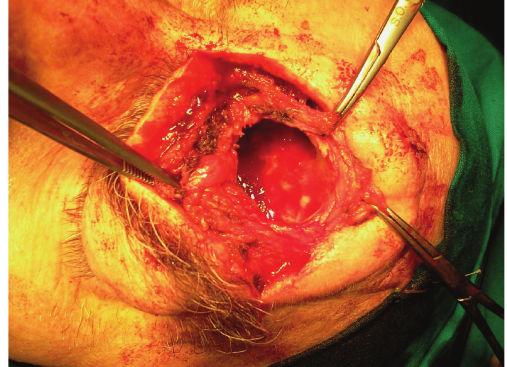
Figure 2: Intraoperative photograph shows the opening of the frontal sinus with Lynch-Howarth procedure.